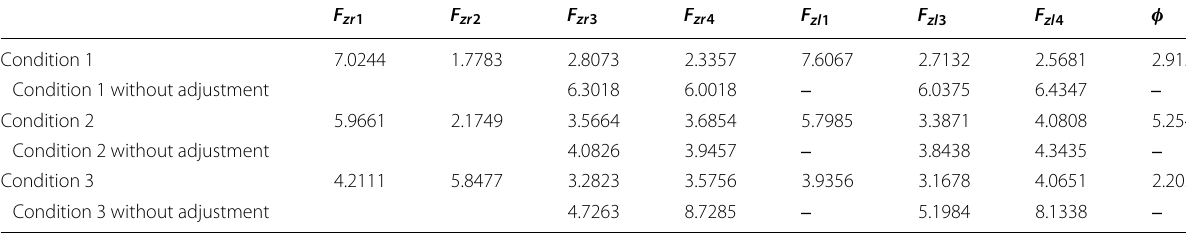
Table 4 Normalized errors (data without noise)